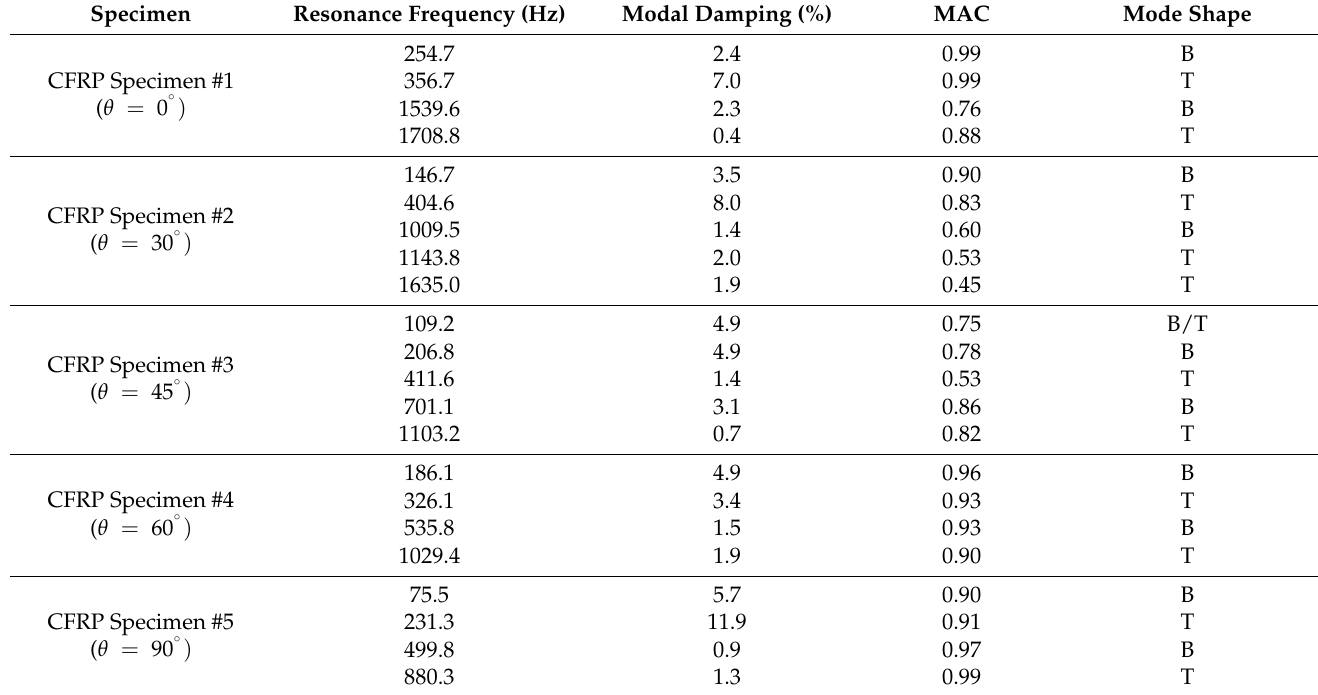
Table 3. Selected modes of CFRP specimens having several similarities with the SCS13A